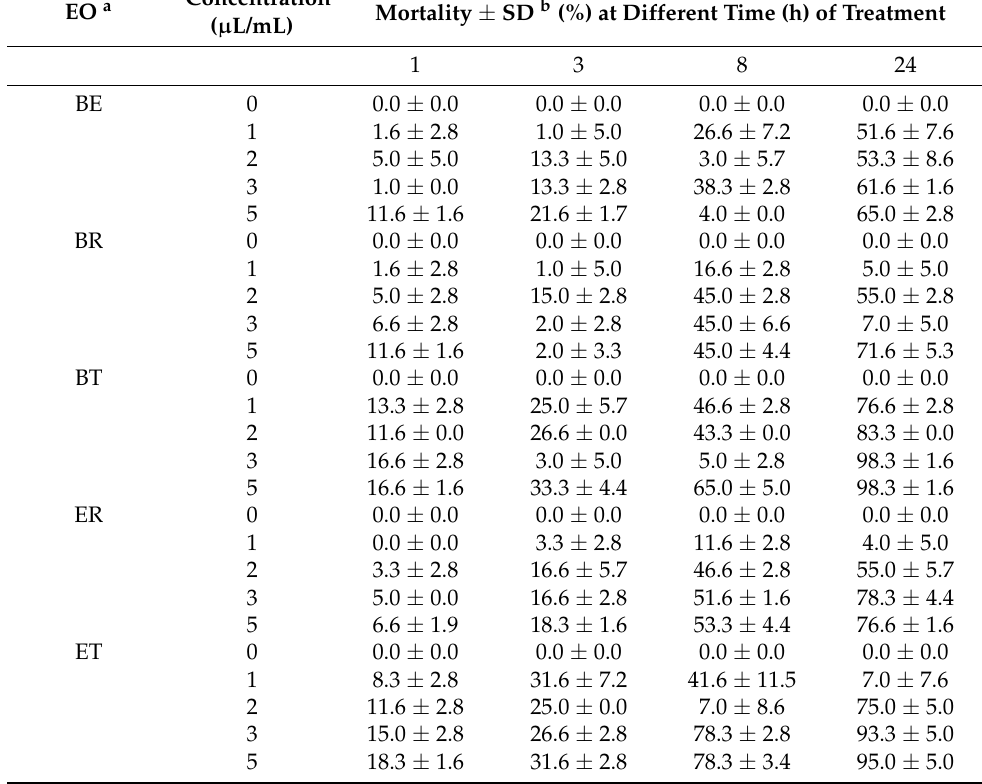
Table 3. Mortality of aphids M. persicae after contact treatment with mixtures of six essential